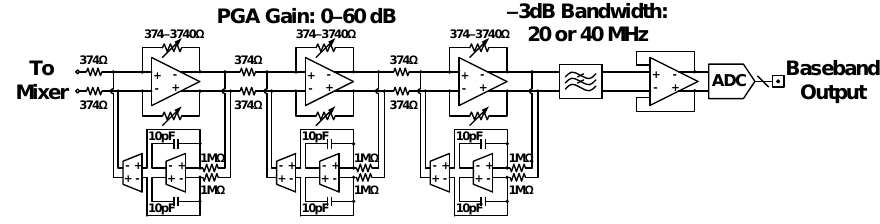
Figure 7. Circuit schematic of the baseband